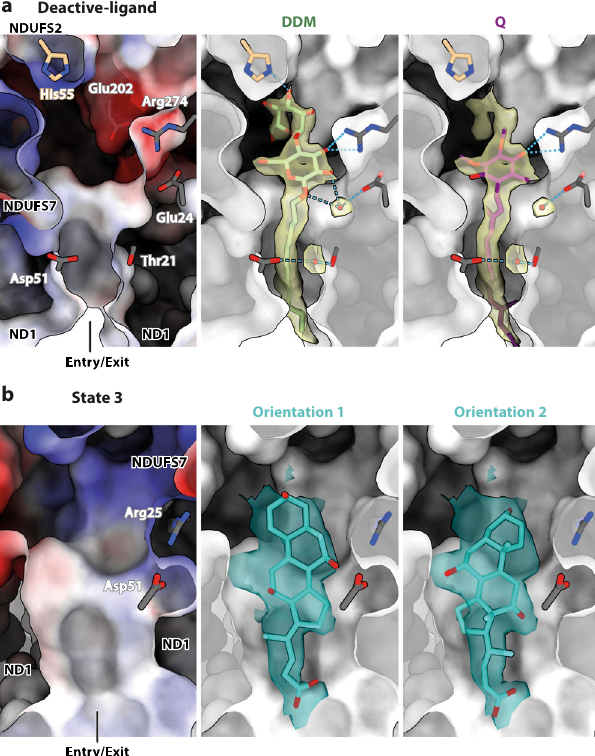
Fig. 5 Ligands bound at the entrance of the Q-binding site of complex I. A clipped view of the surface representation of the entrance to the Q-binding channel in the ( a ) deactive-ligand and ( b ) state 3 models [coloured by Coulombic electrostatic potential (left) or by depth, in black and white (middle and right)]. a Cryo-EM density of the ligand in the deactive-ligand composite map (see Methods) at a map threshold of 4 (transparent yellow) in UCSF ChimeraX 51 , modelled as either a DDM (middle) or a Q 10 (right). Residues H-bonded to the ligand or surrounding water molecules are shown and labelled. The model-map CC mask values for the DDM and Q 10 (clipped to Q 3 ) are 0.74 and 0.70, respectively. b Cryo-EM density of the ligand in the state 3 map at a map threshold of 4.5 (transparent teal), modelled as a cholate molecule in two different orientations. Residues within H-bonding distance to the ligand are shown and labelled. The model- map CC mask values for the primary and secondary cholate orientations are 0.65 and 0.67,